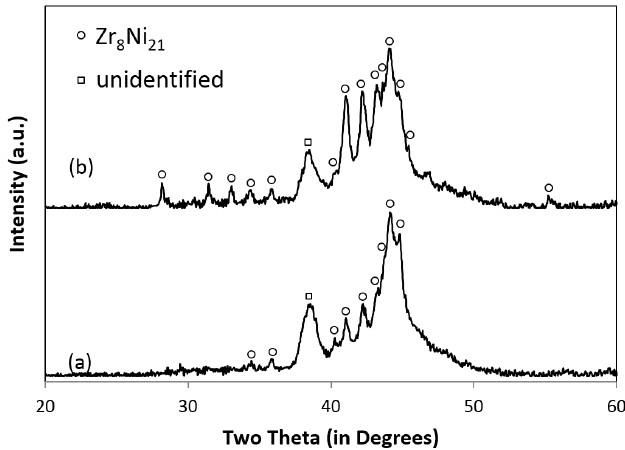
Figure 1. XRD patterns using Cu-K α as the radiation source for Zr 8 N 21 as-cast ( a ) and after an 8-h annealing at 960 °C in an Ar environment ( b